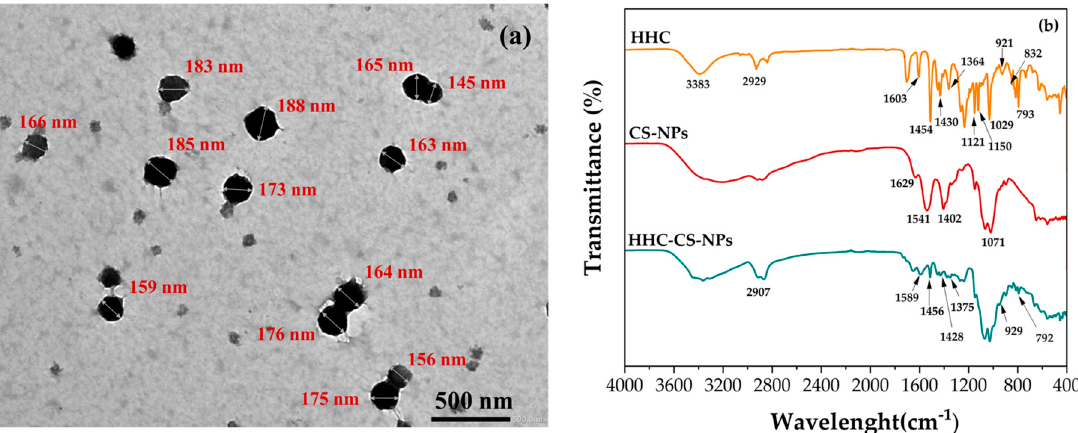
Figure 2. ( a ) TEM analysis of optimized HHC ‐ CS ‐ NPs (at 15,000× magnification) and ( b ) FTIR spectra of HHC, CS ‐ NPs, and optimized HHC ‐ CS ‐ NPs.